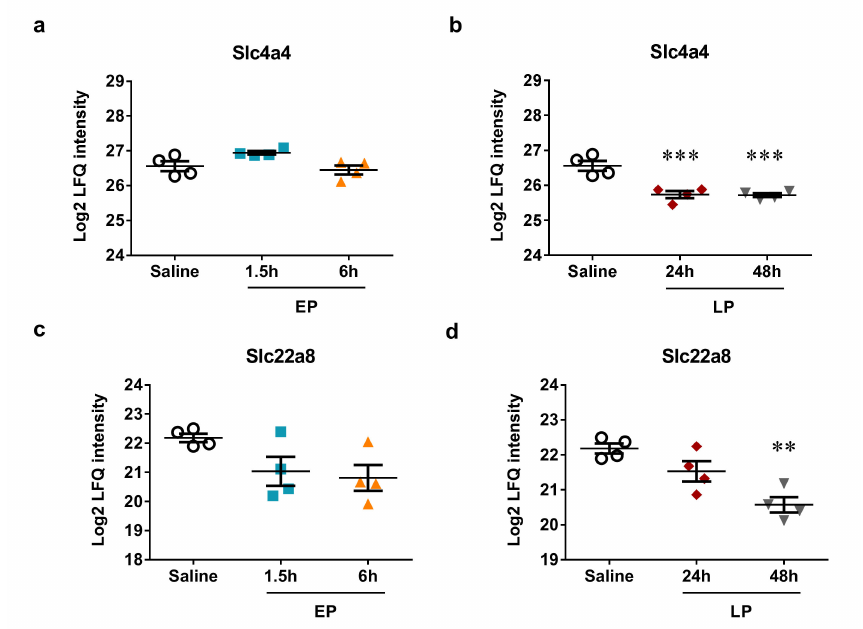
Figure 9. Protein expression of transporters that are predicted miRNA targets in mouse kidneys after LPS administration. Log2 transformed label-free quantification (LFQ) intensity values of proteins were determined by mass spectrometry. Left column: EP, right column: LP. ( a , b ) Slc4a4; ( c , d ) Slc22a8. Data are expressed as mean ± SEM; one-way ANOVA; **: p < 0.01, ***: p <